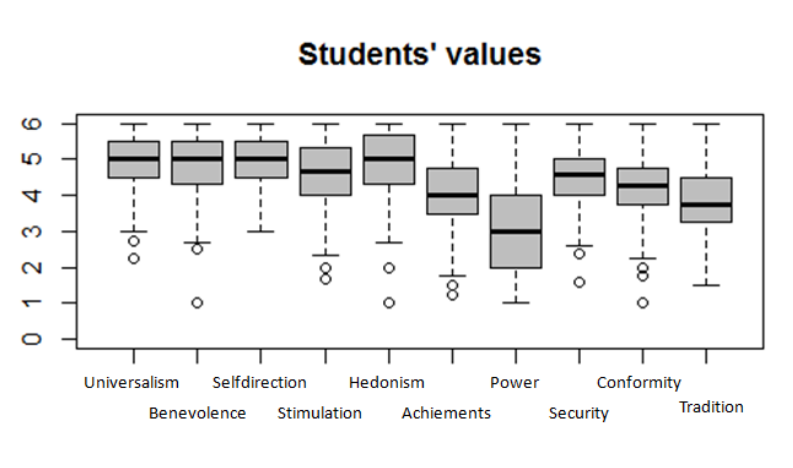
Figure 2 . Students' values Values and satisfaction with life reported by students related to Education program, gender and living standard, are shown in Table 2. Students of Primary Education presented higher importance to power and achievements (both p<0.05). There were differences in values by gender and living situation. Significant differences by gender were found in hedonism, security (both p <0.05), universalism, self-direction, stimulation (p <0.01 for all three), benevolence and power (p = 0.000 for both). Women had higher results than men as far as benevolence, universalism, self-direction, stimulation, hedonism and security were concerned. Males reported greater importance to power than females. Power also showed relevant differences (p = 0.010), depending on the student’s living standard. Those who lived with their families gave greater importance to power than students not living with their